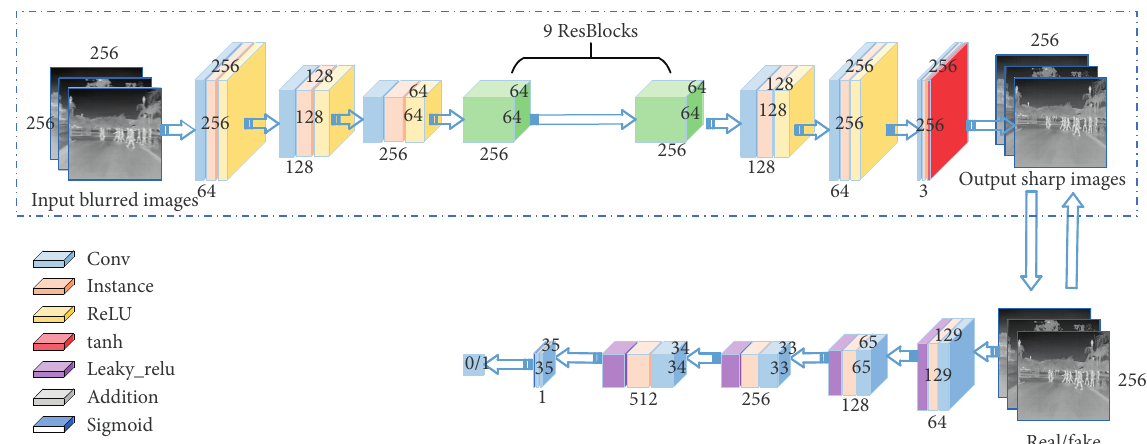
Figure 2: The model architecture of the method is proposed. Top: generator model. Bottom: discriminator